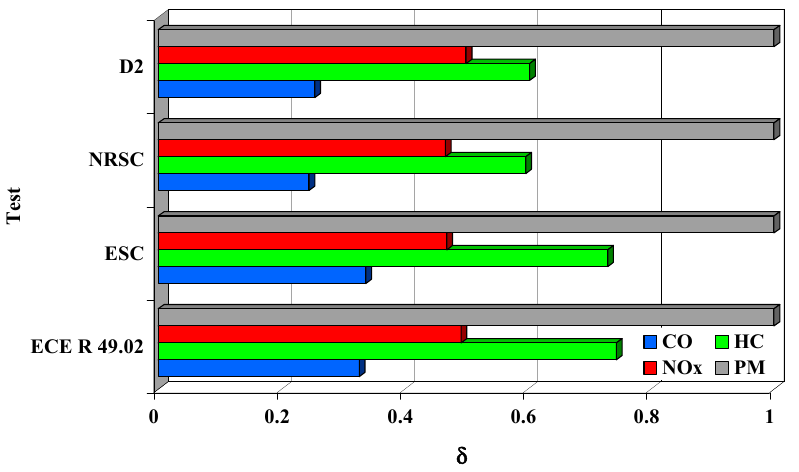
Figure 8. The relative decrease in the specific brake emission of pollutants due to replacing diesel fuel with natural gas as the Cummins 6C 8.3 engine